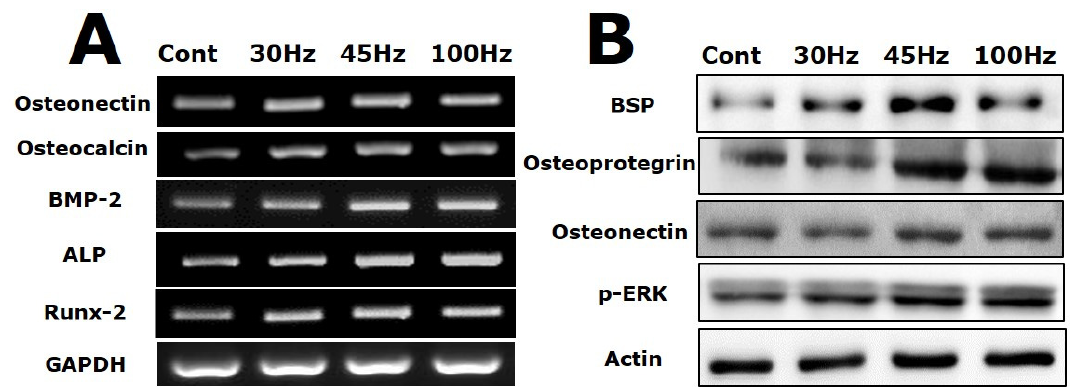
Figure 4. The mRNA ( A ) and protein ( B ) levels of osteogenic markers in human dental pulp stem cells subjected to mechanical vibration for 14 d. Relative mRNA levels of the indicated markers (osteonectin, osteocalcin, BMP-2, ALP, and Runx-2) were measured using Image J software. The mRNA levels of osteocalcin, BMP-2, ALP, and Runx-2 were increased at 45 Hz and 100 Hz, especially osteonectin and Runx-2, whose mRNA levels were significantly higher at 45 Hz than in the control. Quantitation of the p-ERK, BSP, osteoprotegerin, and osteonectin protein levels. The levels of p-ERK, BSP, osteoprotegerin, and osteonectin were increased at 45 Hz compared with the control.